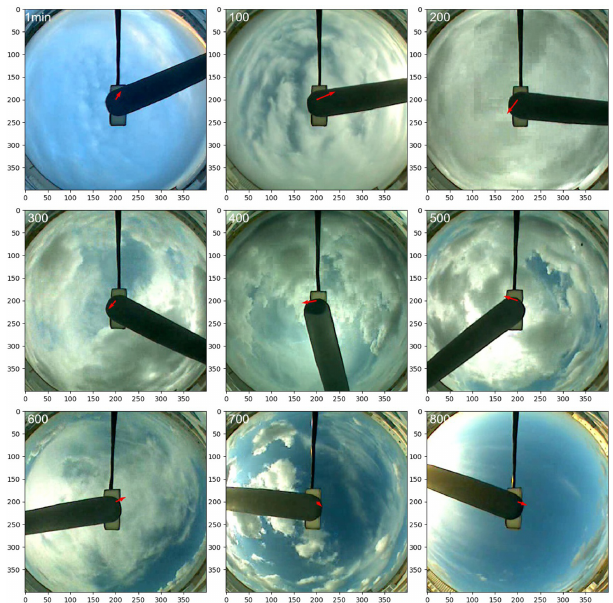
Figure 4. Varying sky conditions on 26 July 2016, from 06:36 to 20:35CDT (11:36–01:35 the next day in UTC) at 100min inter- vals over Lamont, OK. A sky area of 400 × 400 pixels is cropped and used for CMV computation. The top of the image points to the north, and the red arrow shows the direction of motion for that